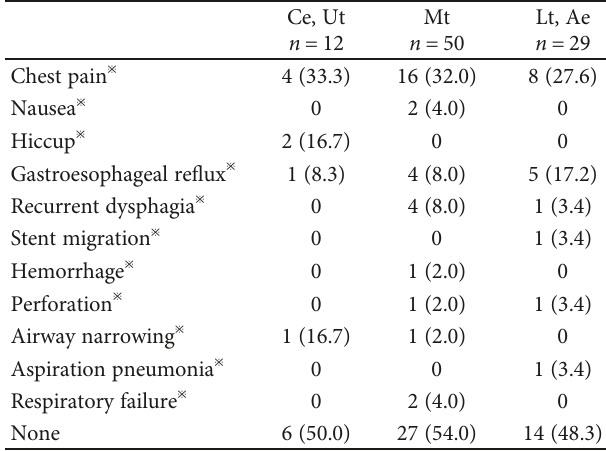
Table 6: Relationships of complications and lesion location ( n = 91 times, number